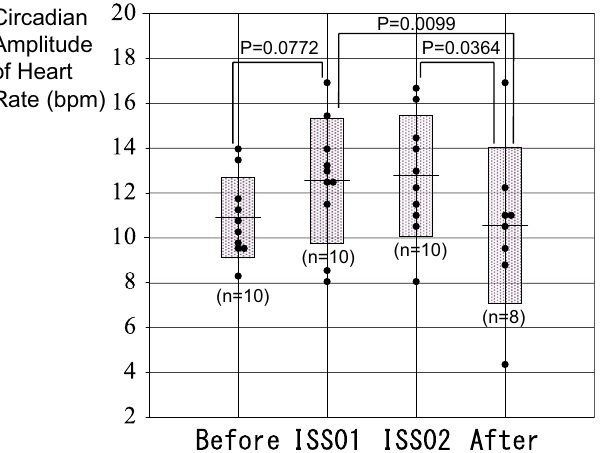
Figure 2. Change in the circadian amplitude of HR related to the space mission. The circadian amplitude of HR increased during spaceflight from 10.90 ± 1.79 bpm (Before) to 12.54 ± 2.78 (ISS01), 12.77 ± 2.69 (ISS02), returning to 10.55 ± 3.49 (After).